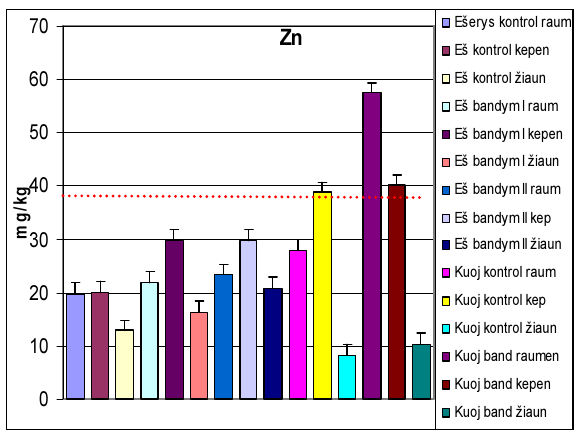
Fig. 5. Heavy metal concentrations (mg/kg) in fish tissues from water contaminated with zinc in